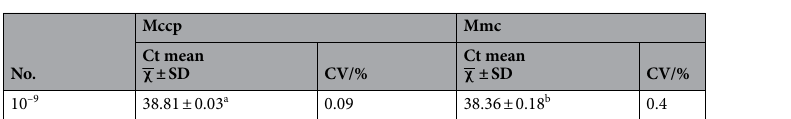
Table 2. Comparison of LOD in the detection of Mmc and Mccp. Different lowercase letters in the same row mean significant difference (0.01 < P < 0.05). The average Ct values differences between the two pathogens were significant (P = 0.012 <